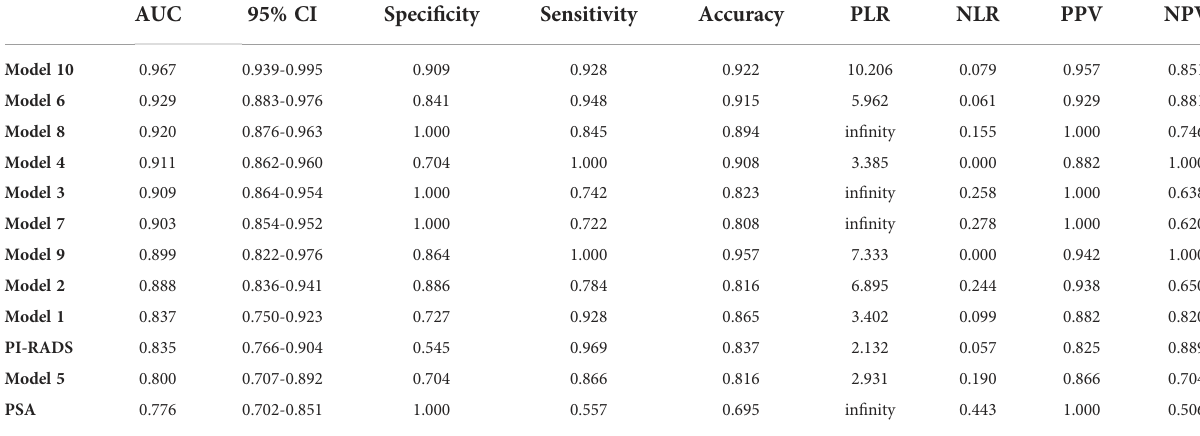
TABLE 2 ROC curve analysis in the training